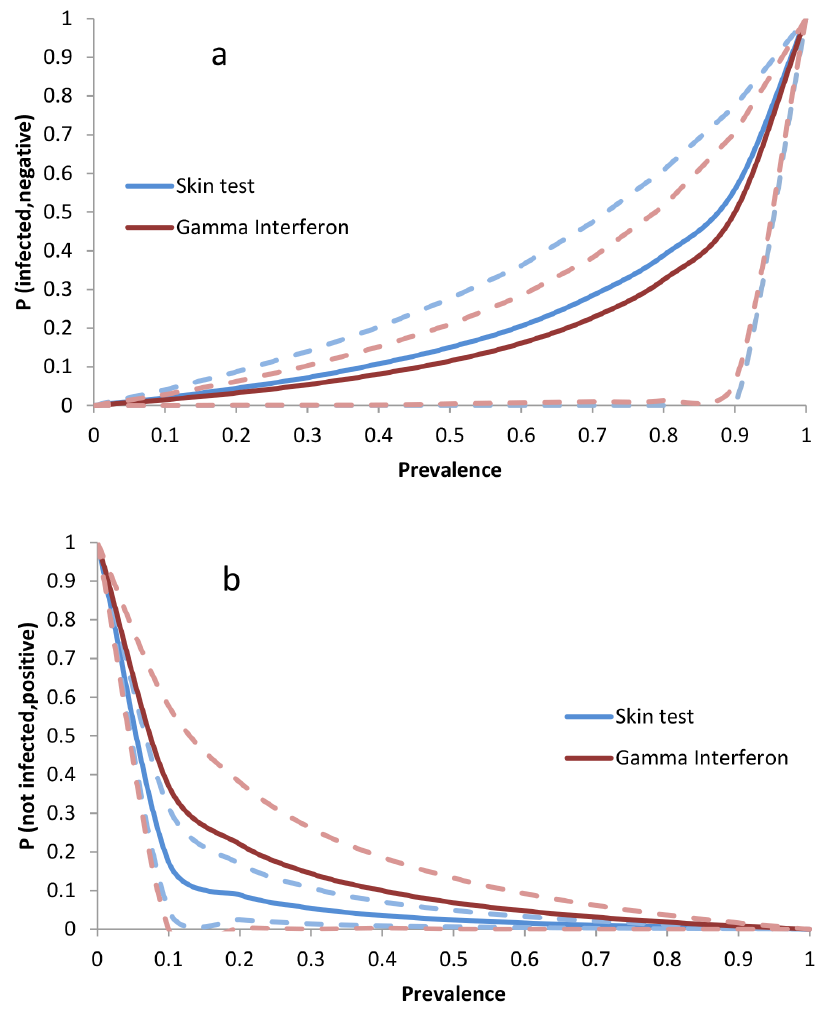
Figure 4. The probability of false SICCT and c IFN results in individual animals. The probabilities of a randomly chosen animal which has tested negative to be infected (1-NPV; figure a) and an animal which has tested positive to be uninfected (1-PPV; figure b) are shown as a function of TB prevalence in the herd. Dotted lines give the 95% confidence limits.